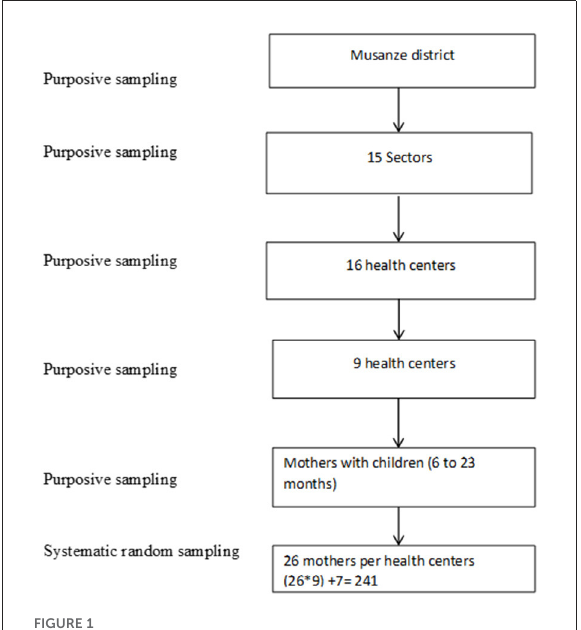
FIGURE1 Sampling schema of the